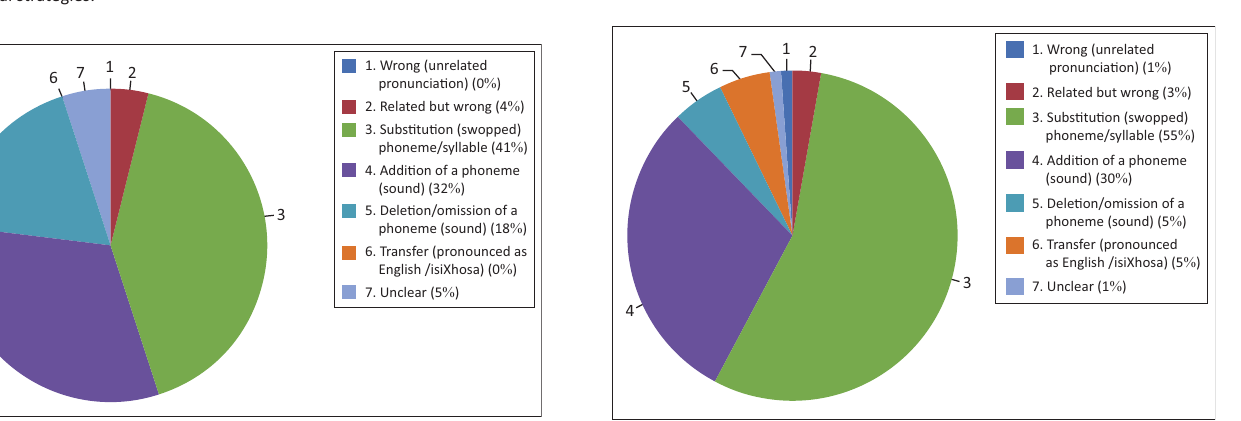
FIGURE 1: School E English real word reading ( n = 9). A mixture of lexical and sublexical